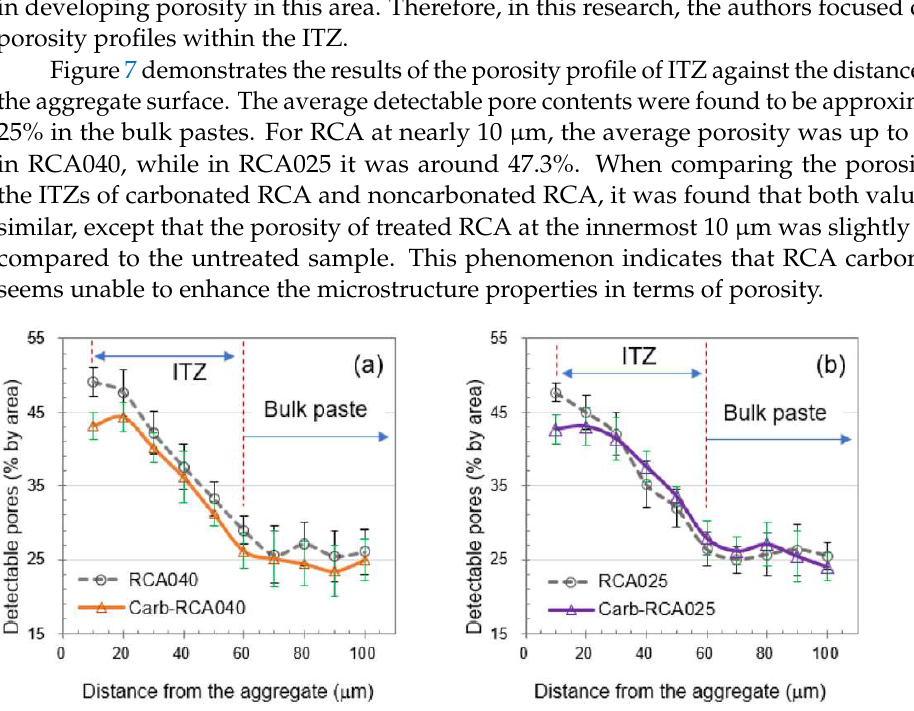
Figure 8. Effect of carbonation treatment on the microhardness of ITZ [39]. Reproduced with per- mission from [39], Hindawi, 2018.